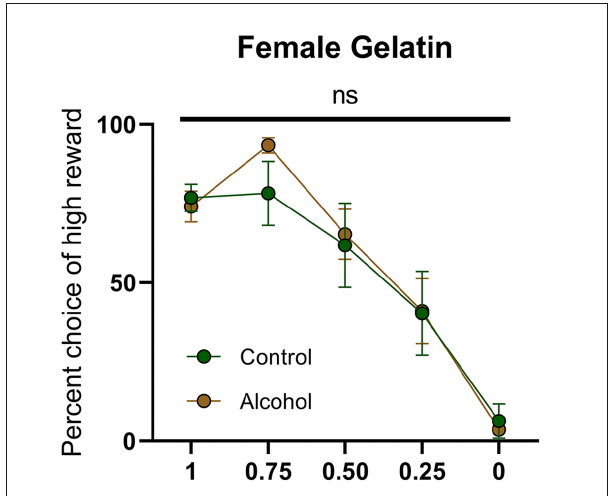
FIGURE5 Psychometric function for choice over probability from alcohol- exposed and control animals. Alcohol-exposed ( n = 8) and control ( n = 8) animals did not differ in choice behavior over the probability of reward for high reward lever or in total reinforcements received. All data are presented as mean ± SEM for the percent of high choice reward according to the probability of reward for high reward lever of 1.00, 0.75, 0.50, 0.25, and 0.00. ns p > 0.05.